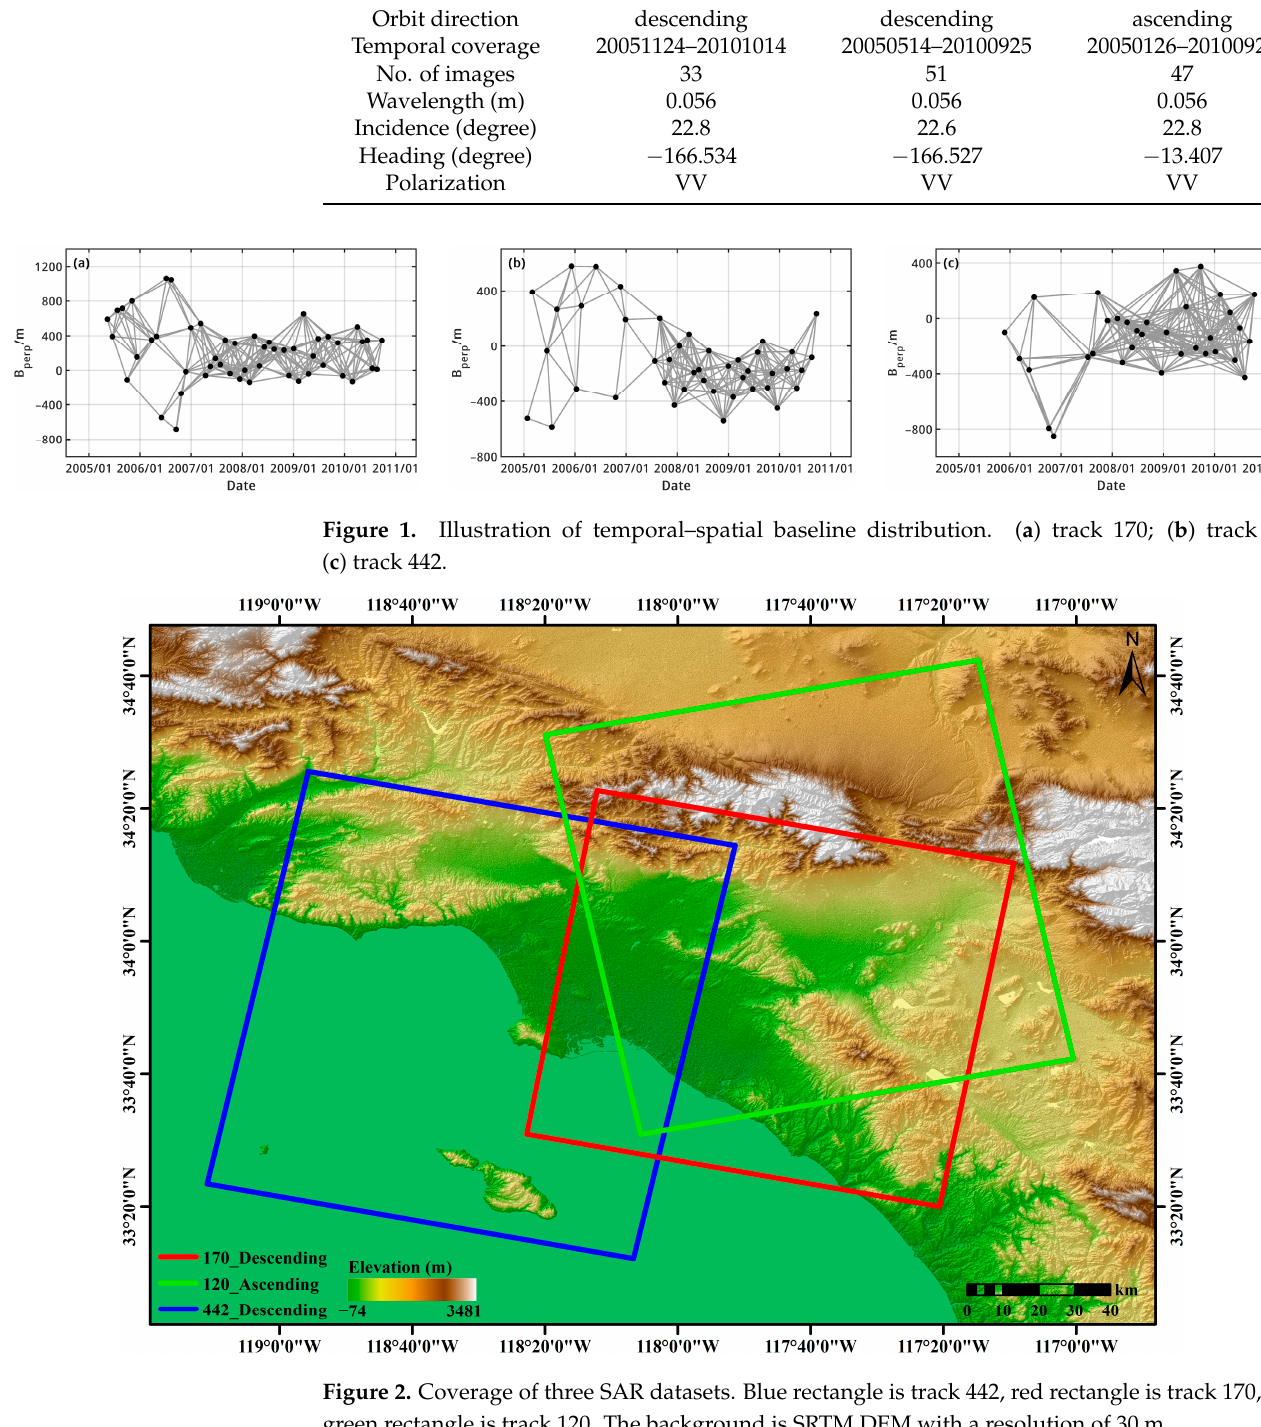
SAR results. The SCIGN is one of the most densely distributed GPS networks in the world,